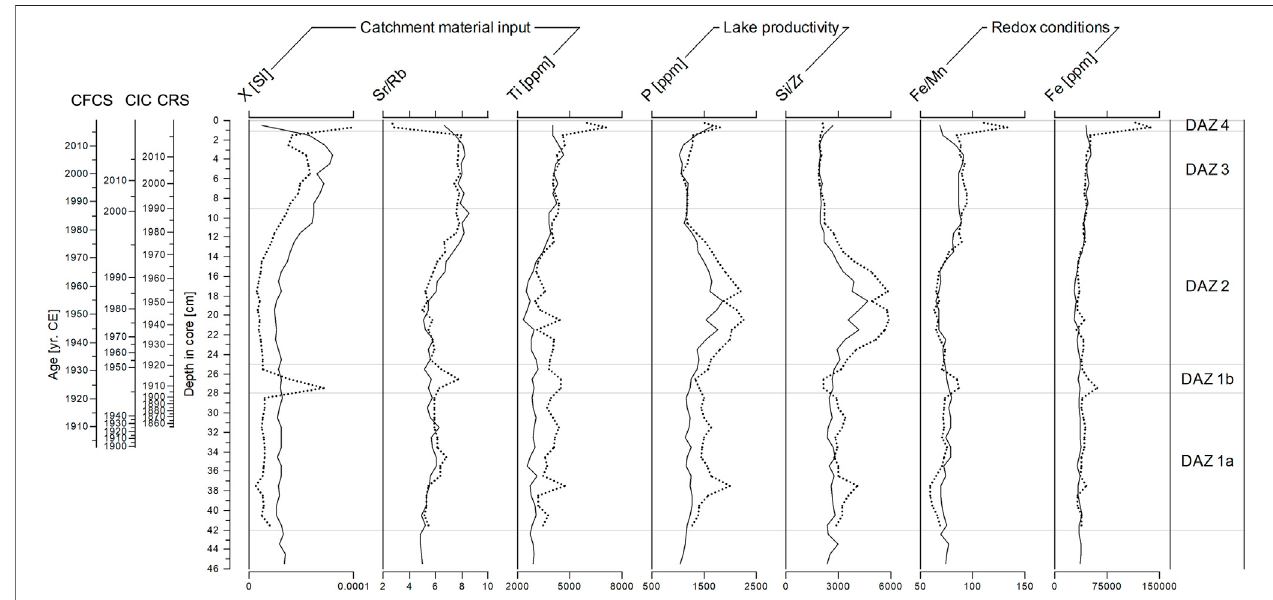
FIGURE3| Down-corevariationsofselectedgeophysical(massdependentmagneticsusceptibility)andgeochemicalproxies(Ti,P,andFeconcentrations;Sr/Rb, Si/Zr, and Fe/Mn ratios) in the cores SUZ1 (dotted line) and SUZ3 (solid line).